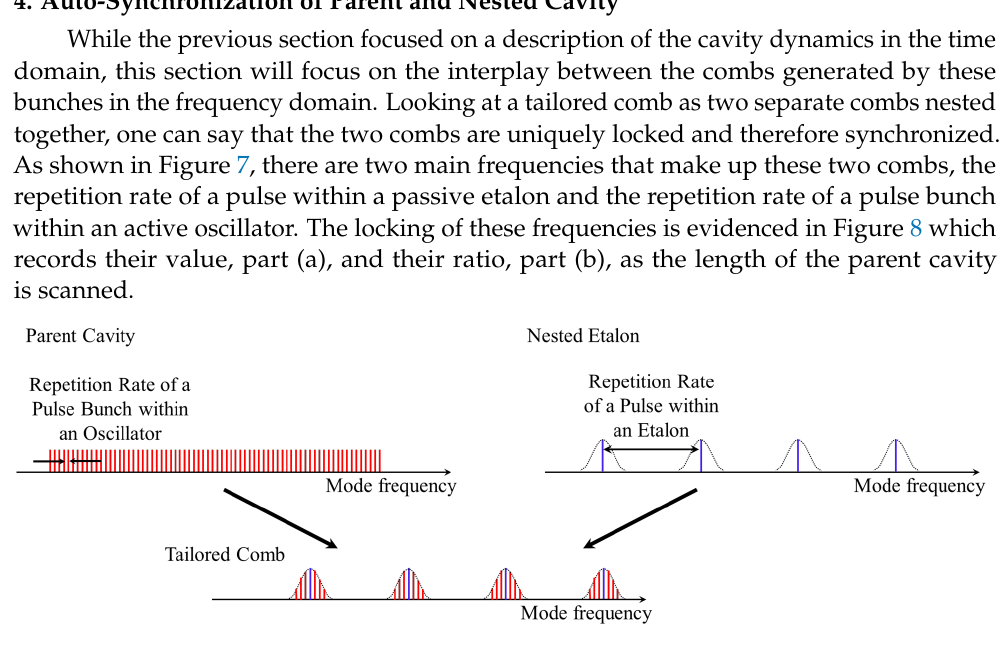
Figure 7. This figure shows the standard mode-locked comb, on the left, and the resonant FP spectrum, on the right coming together to form the tailored comb, on the